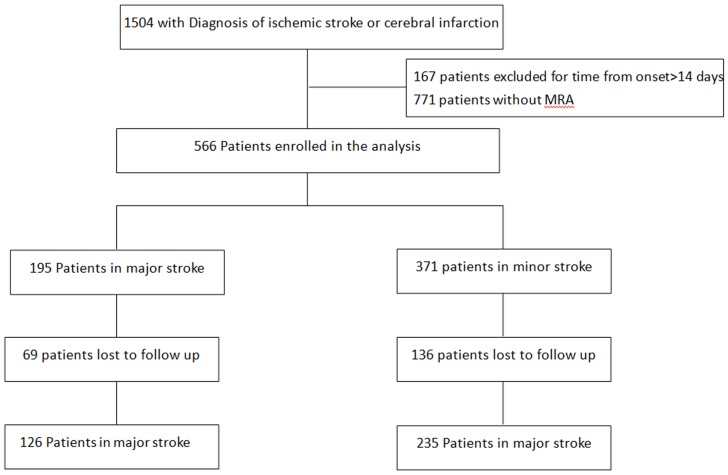
Flow Chart of the Patients Enrolled.